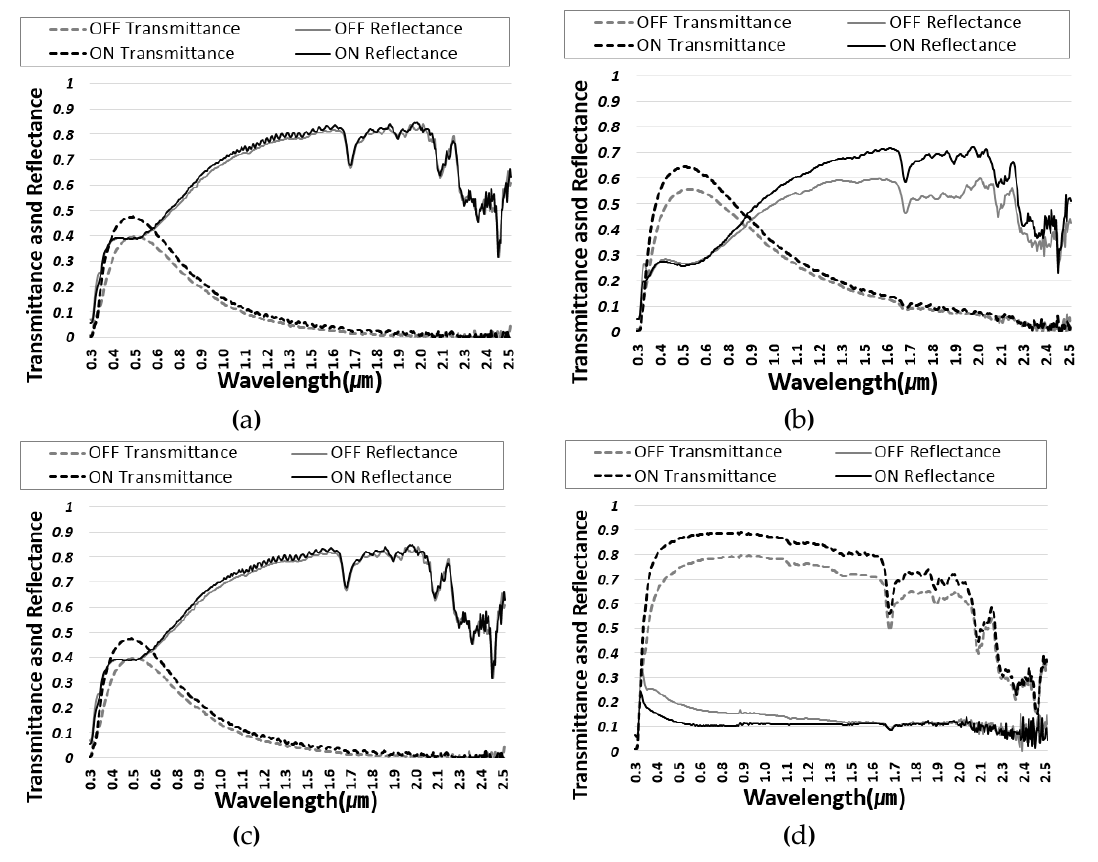
Figure 3. Optical properties data by PDLC film type. Table 1. Optical properties data by PDLC film type derived using Lawrence Berkeley National Laboratory (LBNL) Optic 6 program.